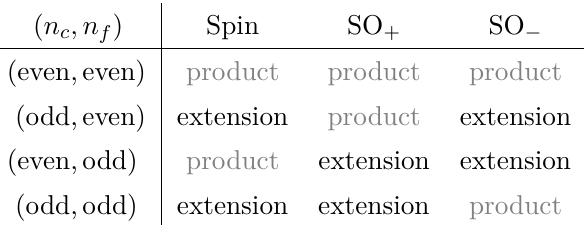
Table 4 . How the Z 2 1-form symmetry and the SU( N f ) / Z 2 0-form flavor symmetry are combined in so (2 n c ) QCD. The label ‘product’ means that they form a direct product, while the label ‘extension’ means that they form a nontrivial